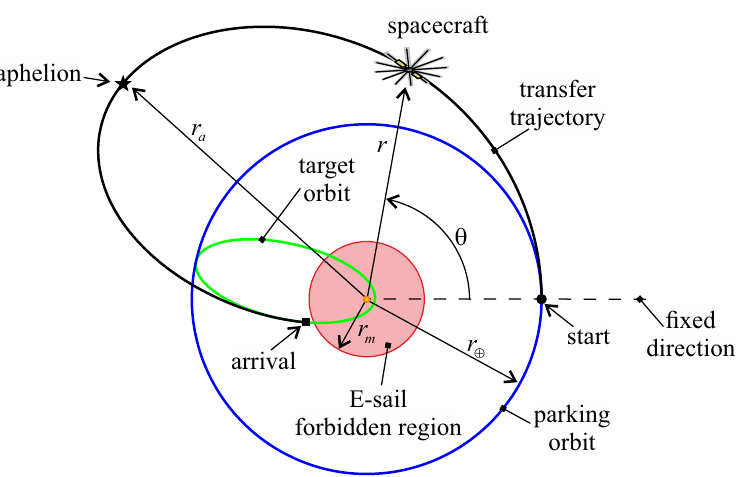
Figure 3. Reference frame and orbit